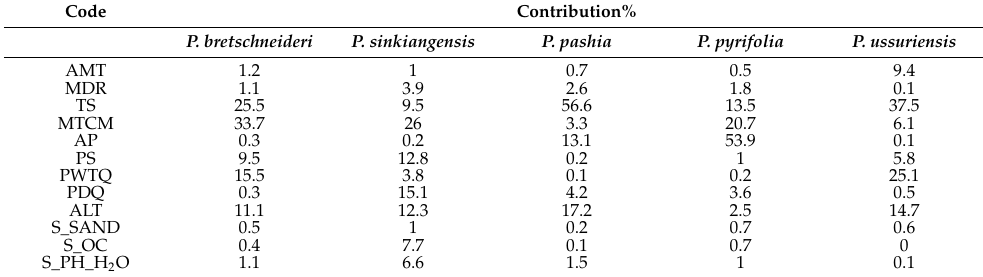
Figure 1. Maxent model accuracy verification diagram of five Pyrus species. Table 1. Percentage contributions of environmental variables used in